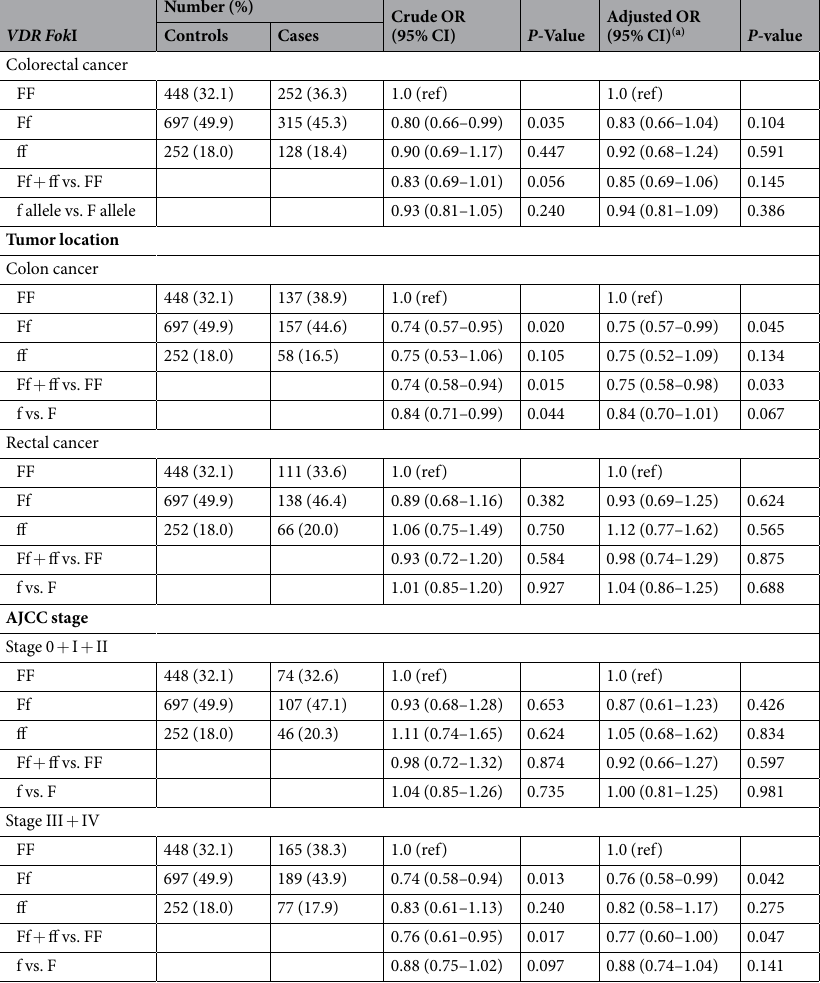
Table 1. Association between VDR Fok I polymorphism and the risk of colorectal cancer in the case-control study. (a) Adjusted for age, sex, BMI, education, family history of colorectal cancer, regular exercise, and total caloric intake. Abbreviations: AJCC, American Joint Committee on Cancer; CI, confidence interval; OR, odds ratio; VDR, vitamin D